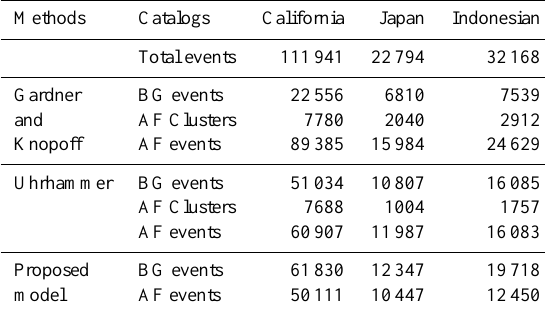
Table 4. Comparative results for the proposed model and that of Gardner and Knopoff (1974) and Uhrhammer (1986) for decluster- ing of California, Japan and Indonesian